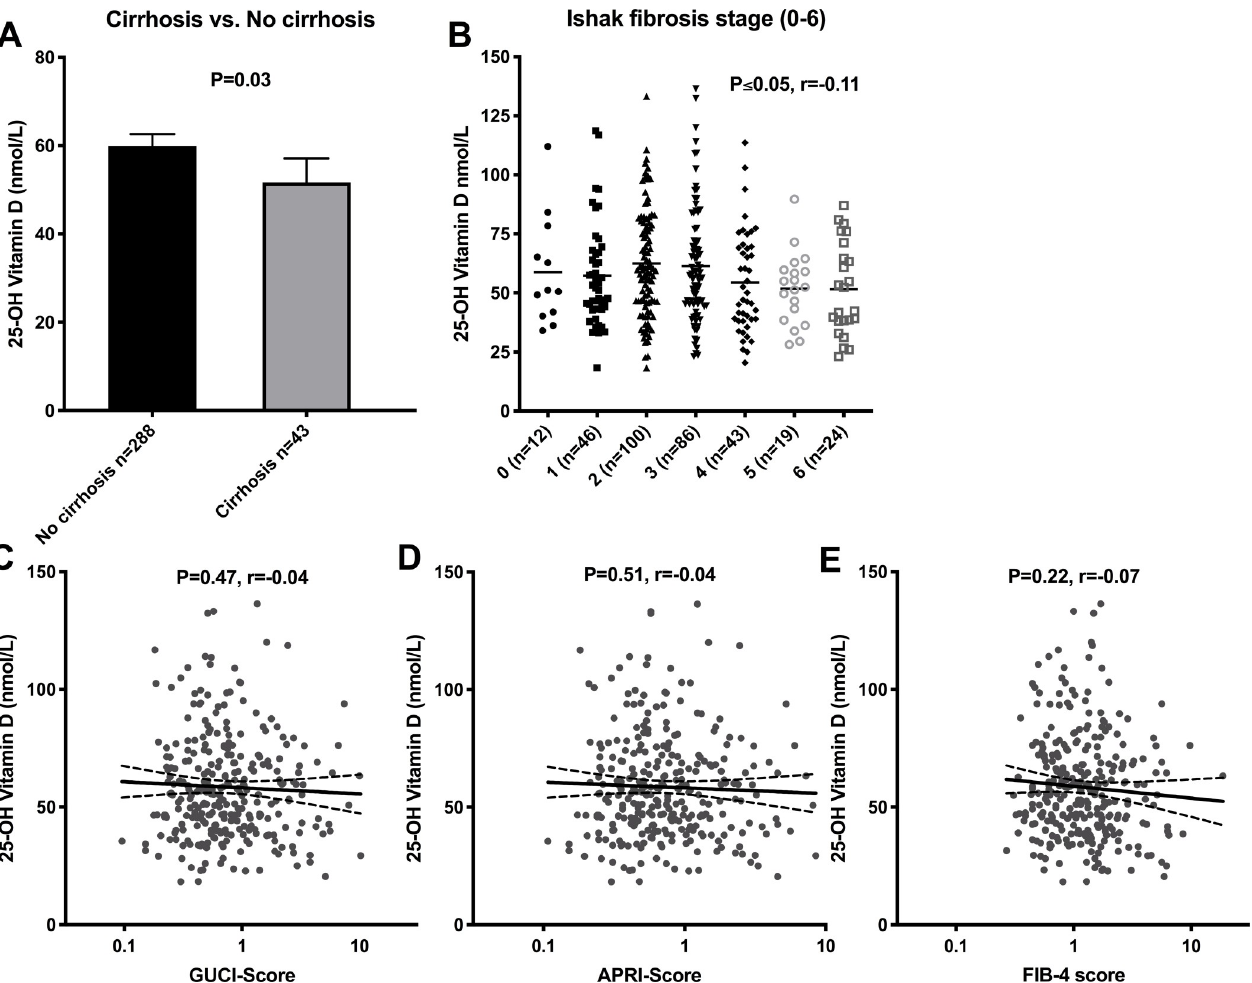
Fig 1. 25-hydroxy vitamin D and liver fibrosis. Bar chart for 25-hydroxy vitamin D and liver cirrhosis (A) and scatter plots for 25-hydroxy vitamin D and Ishak fibrosis stage (B) fibrosis indices GUCI-score (C), APRI-score (D) and Fib-4 score (E). Mean concentration and 95% confidence interval is shown. Statistical significance determined by Student T test and Pearson’s